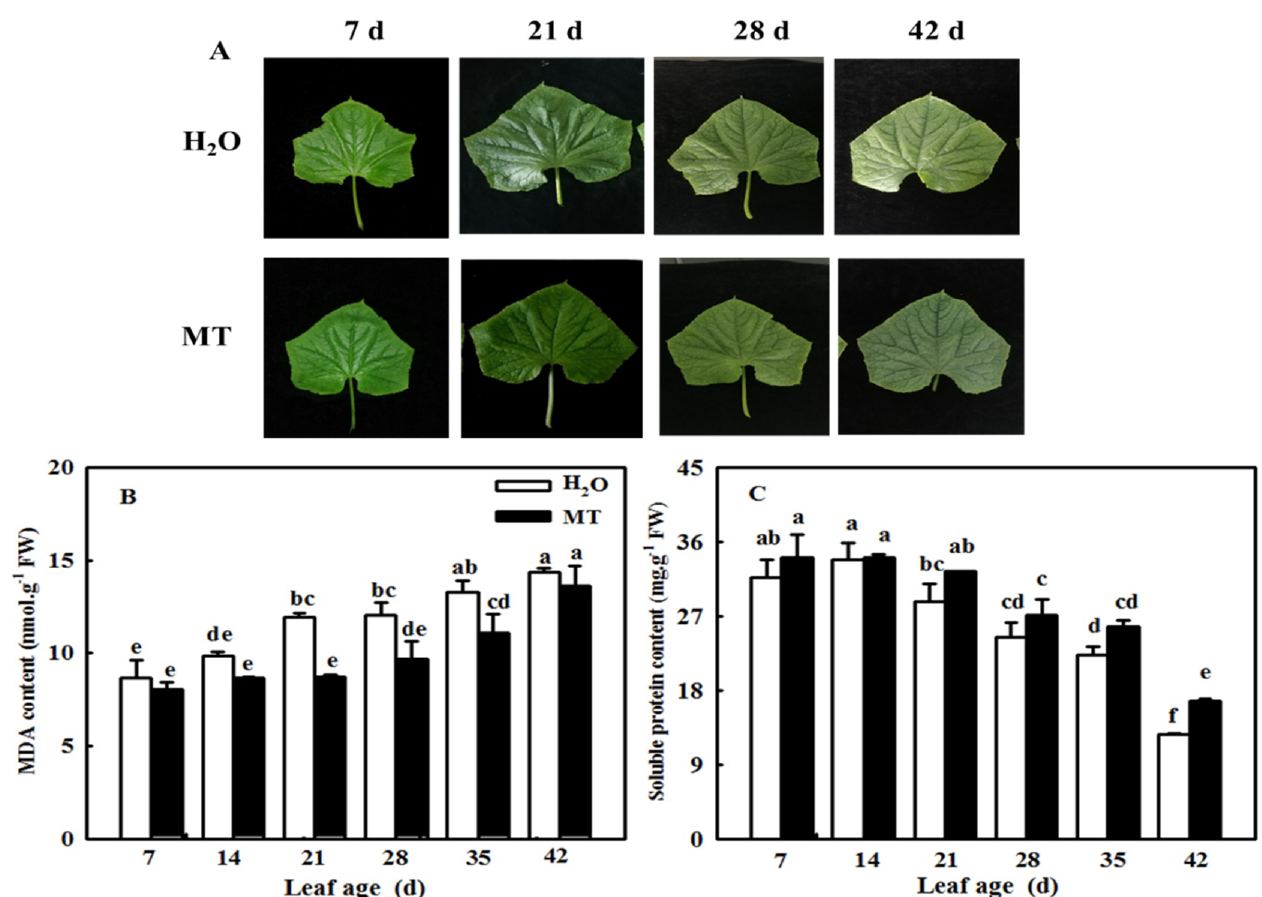
Figure 5. The effect of exogenous MT on MDA and protein contents in different age leaves of cucumber plants in a solar greenhouse. ( A ) Phenotype of leaves at different ages; ( B ) MDA content; ( C ) soluble protein content. At the three-leaf stage, the new leaf at the top was labeled 0 days and then labeled at 7, 14, 21, 28, 35, and 42 days. Meanwhile, cucumber plants were sprayed with 100 µ mol · L − 1 MT every 7 days, and plants treated with H 2 O were the control. The different leaf-age leaves were sampled for MDA and protein content determination. All values shown are mean ± SD ( n = 3). a–f indicate that mean values are significantly different among samples ( p < 0.05).